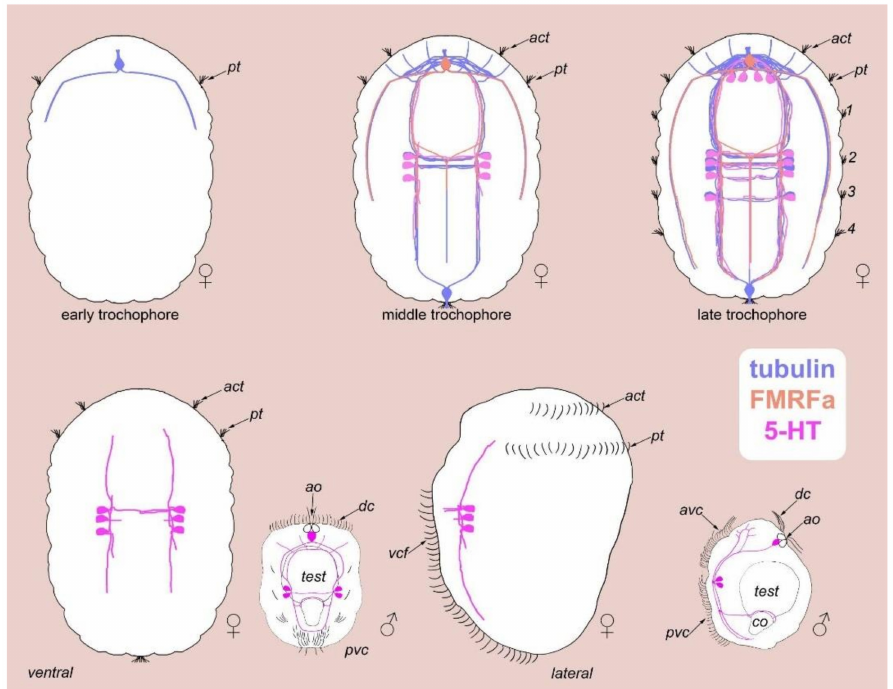
Figure 15. Schematic representation of D. gyrociliatus females nerve development and comparison with dwarf male. The diagram is based on [12]. Females go through three developmental stages: early trochophore, middle trochophore, and late trochophore. The dwarf male 5-HT-like immunoreactive system is similar to the female nervous system during the middle trochophore